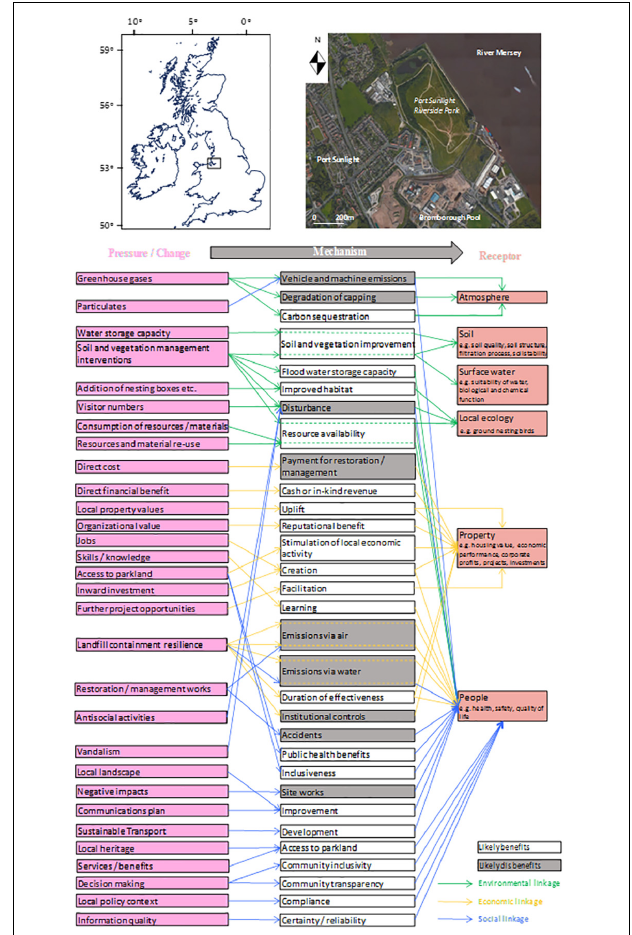
FIGURE 4 | Conceptual site model for sustainability (network diagram) for the Port Sunlight River Park (after Li et al., 2019). Mechanisms are colored depending on whether they are considered deleterious (as gray) or beneficial (white). Linkages are shown as arrows, color-coded to environmental, economic and social elements of sustainability, using green, yellow and blue,